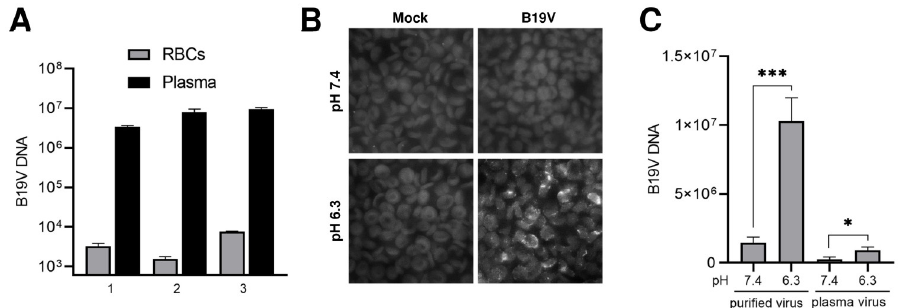
Fig 8. Erythrocytes do not play a significant role as viral decoy targets during B19V viremia. (A) Freshly collected blood samples (with EDTA as anticoagulant) and tested negative for antibodies against B19V, were spiked with B19V (10 9 virions) and incubated for 1h at 37˚C. The plasma and the RBC fractions were separated by centrifugation, the RBCs were washed with PBS (pH 7.4) and the viral DNA was extracted from both fractions and quantified by qPCR. (B) Detection of B19V in the RBC fraction by IF with an antibody against intact capsids (860-55D). (C) A component (s) in human plasma inhibits binding of B19V to RBCs. RBCs (0.5% in 100 μ l PiBS) were incubated at pH 7.4 or 6.3 with B19V (5x10 9 ) directly from an infected plasma sample or after purification by iodixanol density gradient centrifugation. After 1h at room temperature, the erythrocytes were washed four times with the corresponding buffer and viral DNA was extracted and quantified. The results are presented as the mean ± SD of three independent experiments. � , p < 0.05; ��� , p < 0.001.